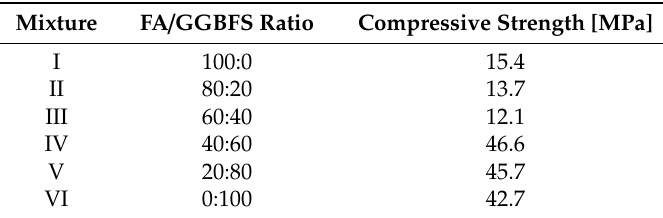
Table 6. The effect of the variation of the compressive strength of some geopolymers mortars based on fly ash and ground granulated blast furnace slag, with heat treatment (72 h/100 °C) [24]. Mixture FA/GGBFS Ratio